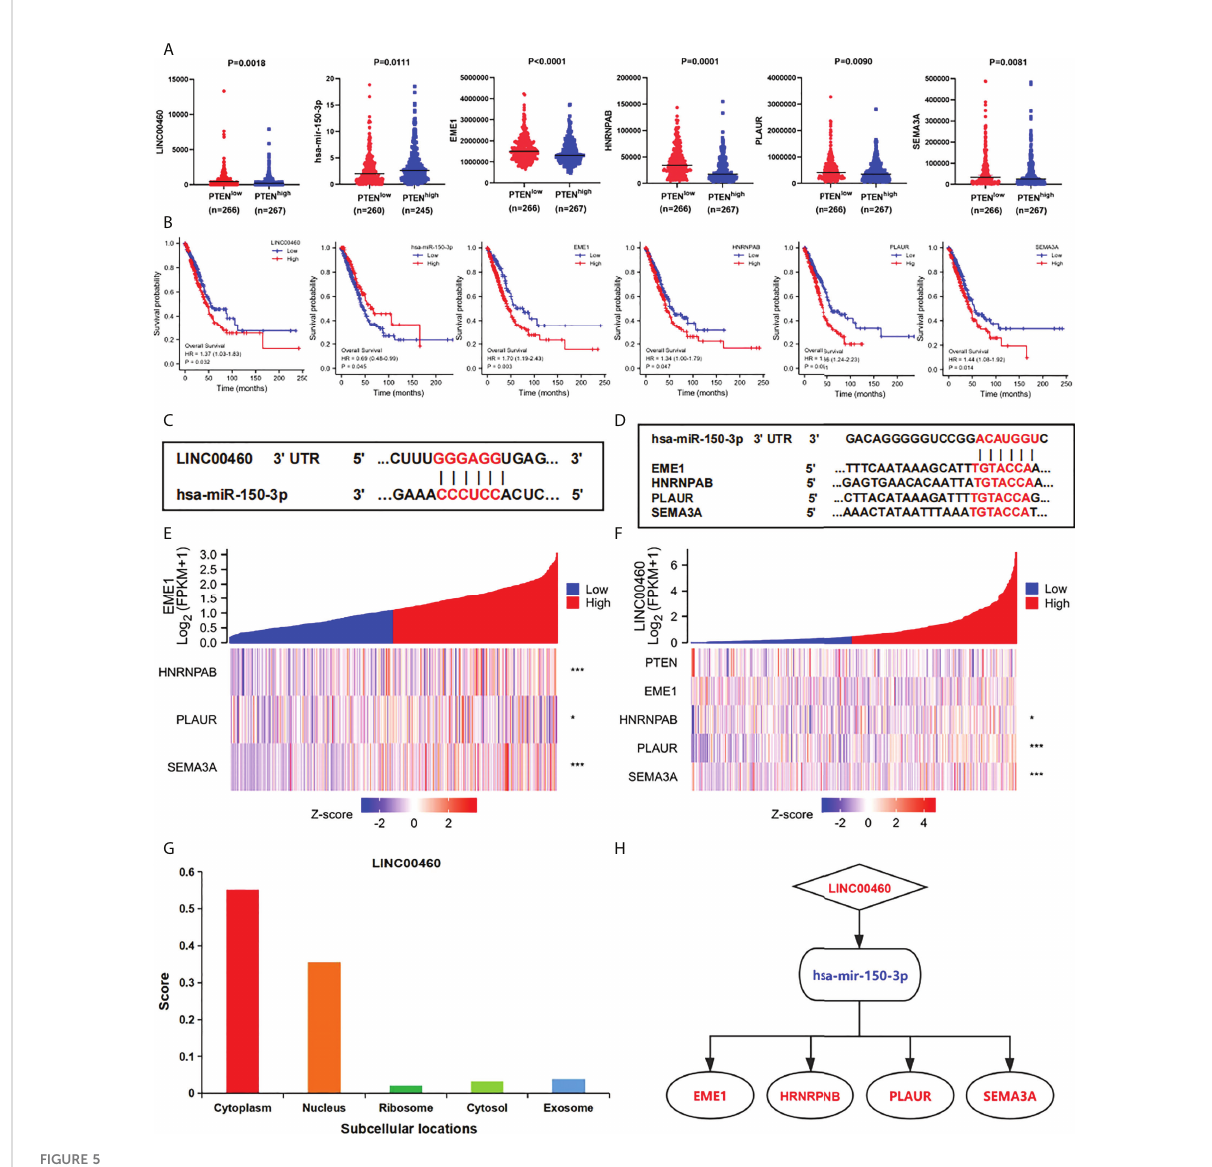
FIGURE 5 Construction of the triple regulatory network. (A) The expression of ceRNAs in PTEN high and PTEN low groups. (B) The OS of ceRNAs in the network. (C) Predictive binding location between miRNA and lncRNA. (D) Predictive binding location between lncRNA and mRNA. (E) Correlation analysis between predictive genes in LUAD. (F) Correlation analysis between predictive ceRNAs and PTEN in LUAD. (G) The cellular localization of LINC00460. (H) The predicted triple regulatory network in LUAD. *p < 0.05; ***p <